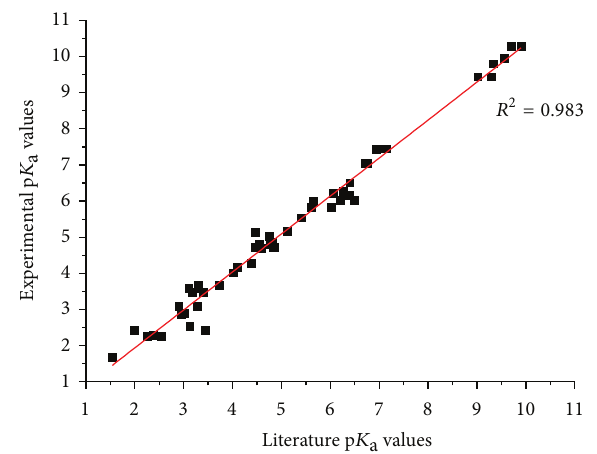
Figure 3: Plot of experimental versus literature p 𝐾 compounds under